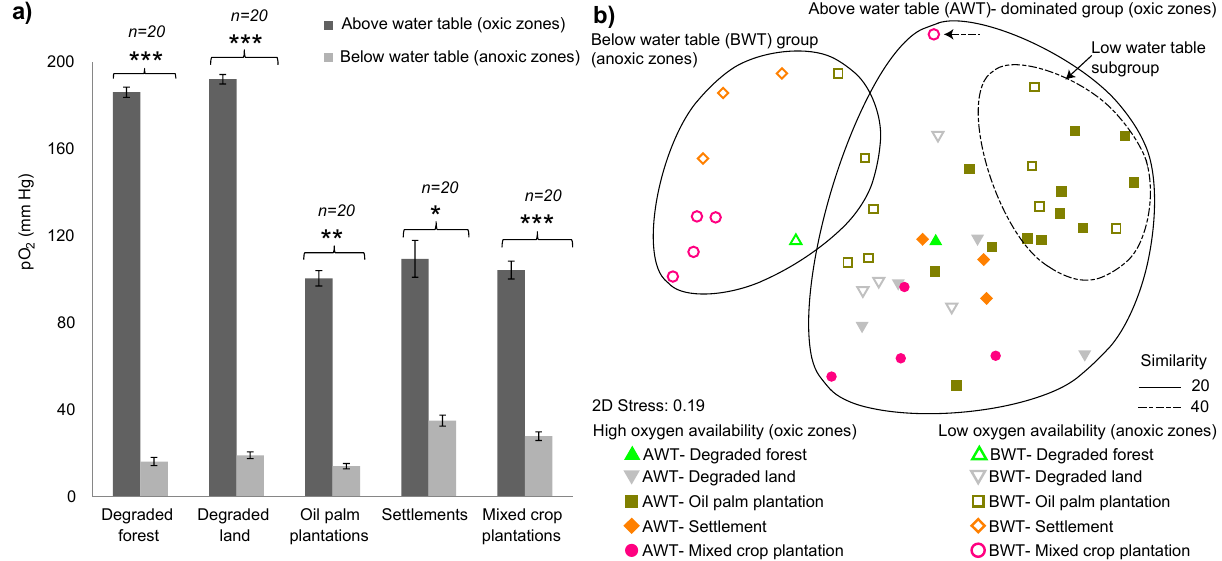
Fig. 2. Oxygen levels ( p O 2 ) , mmHg (a) and nonmetric multidimensional scaling (nMDS) ordination plot based on Bray–Curtis similarities calculated from presence/absence data of 16S rDNA TRFs abundances (b) at above (oxic zones) and below (anoxic zones) water table positions in different land-use types. Level of significance in (a) is ∗ p < 0 . 05, ∗∗ p < 0 . 01, and ∗∗∗ p < 0 . 001, and n =total number of independent measurements.